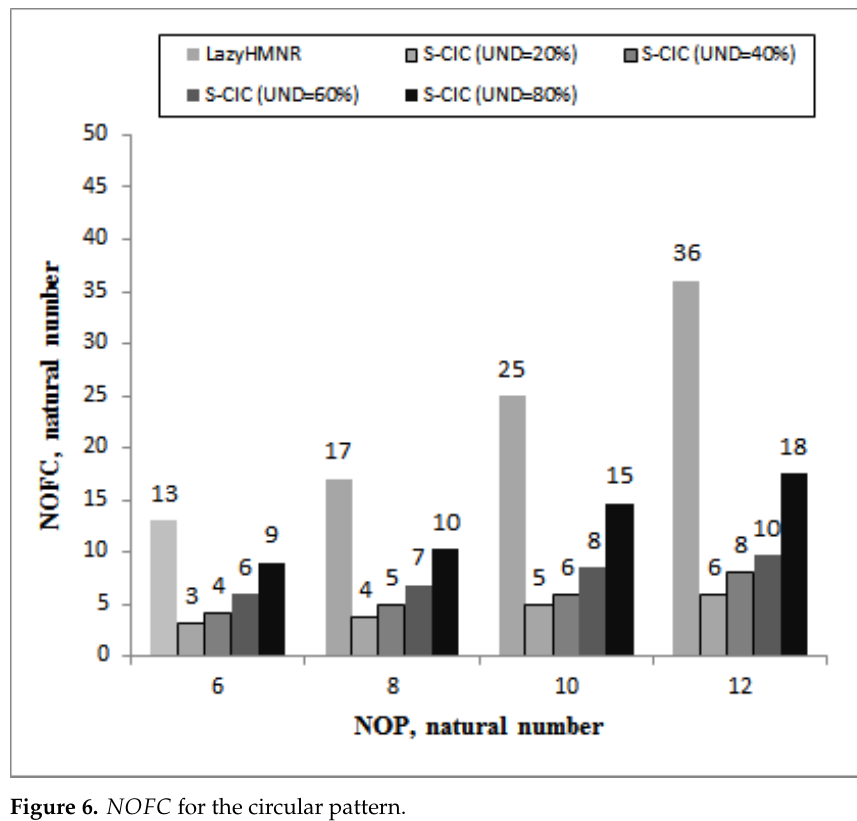
Figure 6. NOFC for the circular pattern.